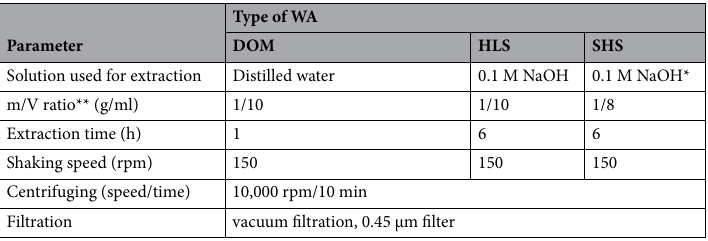
Table 1. Conditions for extraction of SS_WAs. *Before the proper extraction of SHS, dissolved substances, waxes, bitumens were removed; **m/V is the ratio between sludge mass (g) and volume of extractant